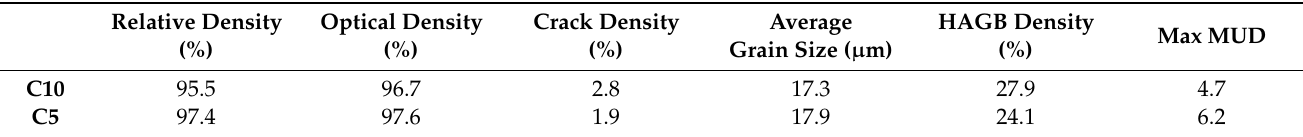
Table 2. Relative and optical densities of as-built Cr specimens with corresponding crack density, average grain size, high-angle grain boundary (HAGB) density, and texture strength. Relative